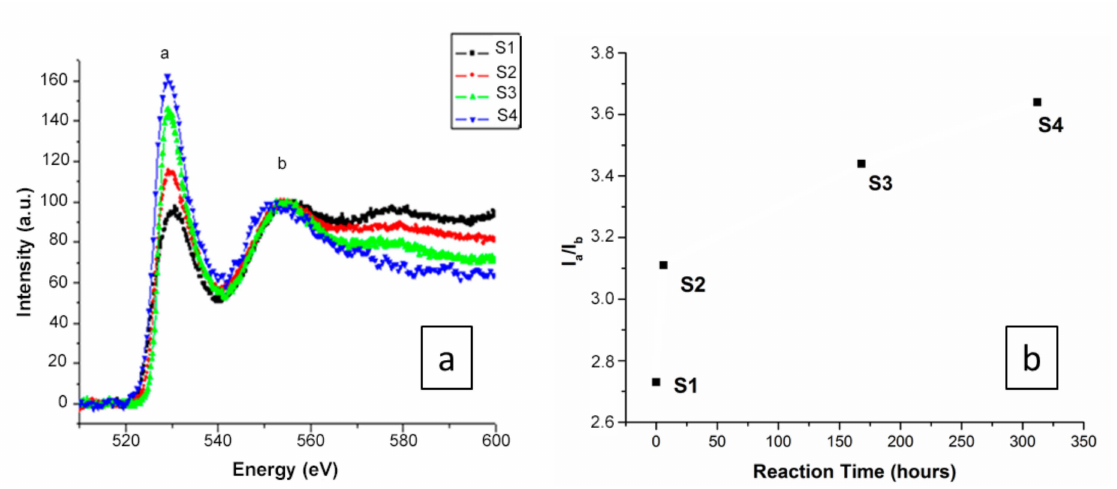
Figure 5. ( a ) Electron energy loss spectra taken of the O–K edges of all compounds. All of the spectra were calibrated at the O–K pre-edge peak position. ( b ) Evolution of the intensity ratio of peaks a to b deduced from the O–K electron energy loss spectroscopy (EELS)